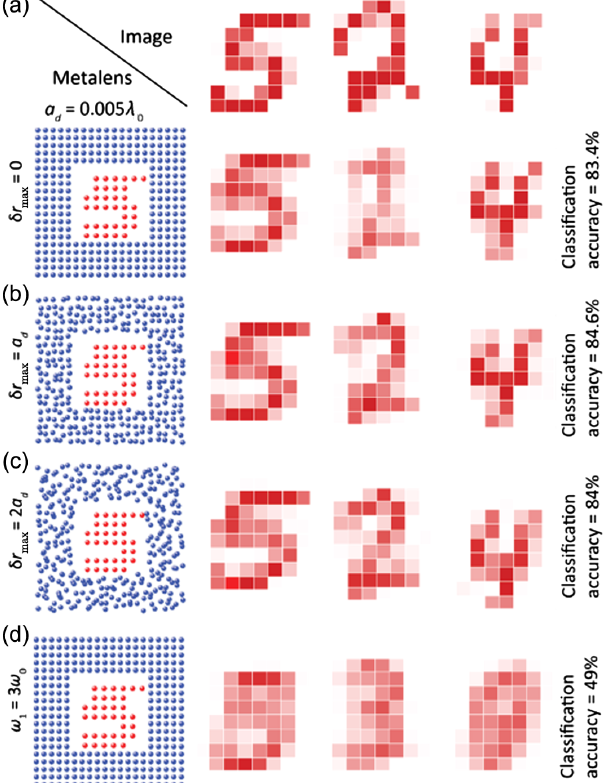
FIG. 8. Influence of absorption losses on image reconstruction FIG. 7. Subwavelength image reconstruction using resonant using UCNN and coupled-dipole method. Examples of subwa- metalenses. (a) A lattice of 300 resonators with a period a d ¼ velength digits reconstructed from arrays of complex field values 0 . 005 λ ω 0 and a resonance frequency 0 (left inset). The examples obtained for different collision of input (top row) and reconstructed (second row) images using UCNN. A lattice with random displacements of resonators in the range (b) δ r ¼ ½ 0 ; a d (cid:2) and (c) δ r ¼ ½ 0 ; 2 a d (cid:2) and the corresponding reconstructed images. (d) A lattice of 300 resonators with a period a ¼ 0 . 005 λ 3 ω d 0 and a resonance frequency 0 (left inset) and corresponding reconstructed images.